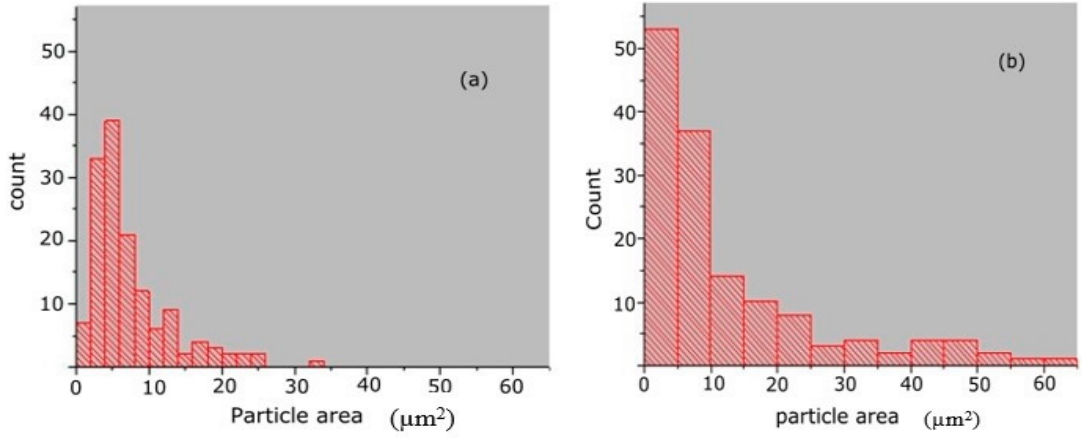
Figure 12. Ratio of grain number (count) to particle area: ( a ) for TMCP steel; ( b ) for QT steel. Comparative analysis indicates a high concentration of grains in the upper surfaces of the QT 690 compared to the TMCP 690 steel. The average difference was 12.7 µm 2 for QT 690 and 7.6 µm 2 for TMCP 690 steel.